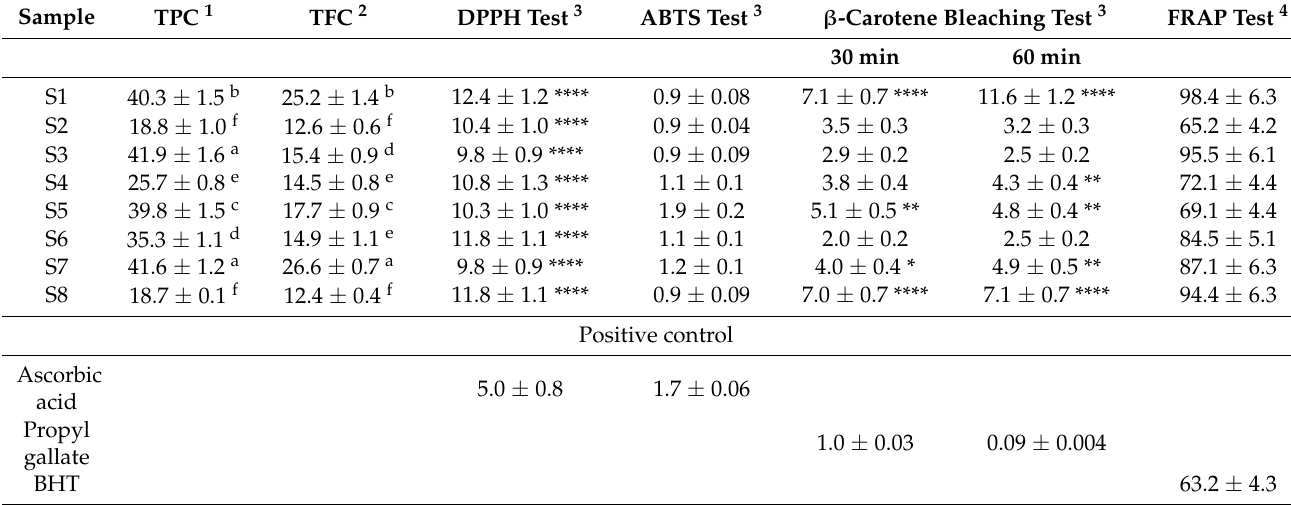
Table 5. Total phenols content (TPC), total flavonoids content (TFC), and antioxidant effects of S. officinalis S1–S8 extracts.